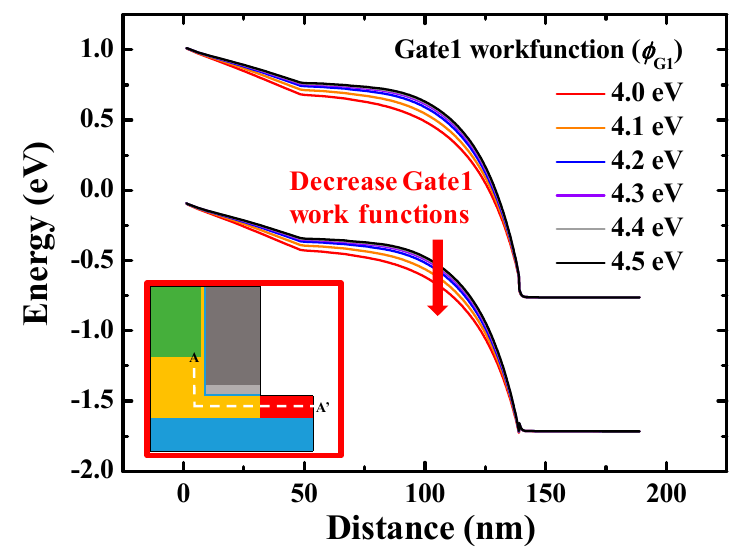
Figure 6. Energy band diagrams with various ϕ G1 (at V DS = 0.7 V). They are obtained from channel-to-drain along the cutline which is indicated in the inset (A-A’). As ϕ G1 decreases, the tunneling barrier between the channel and the drain becomes thicker.